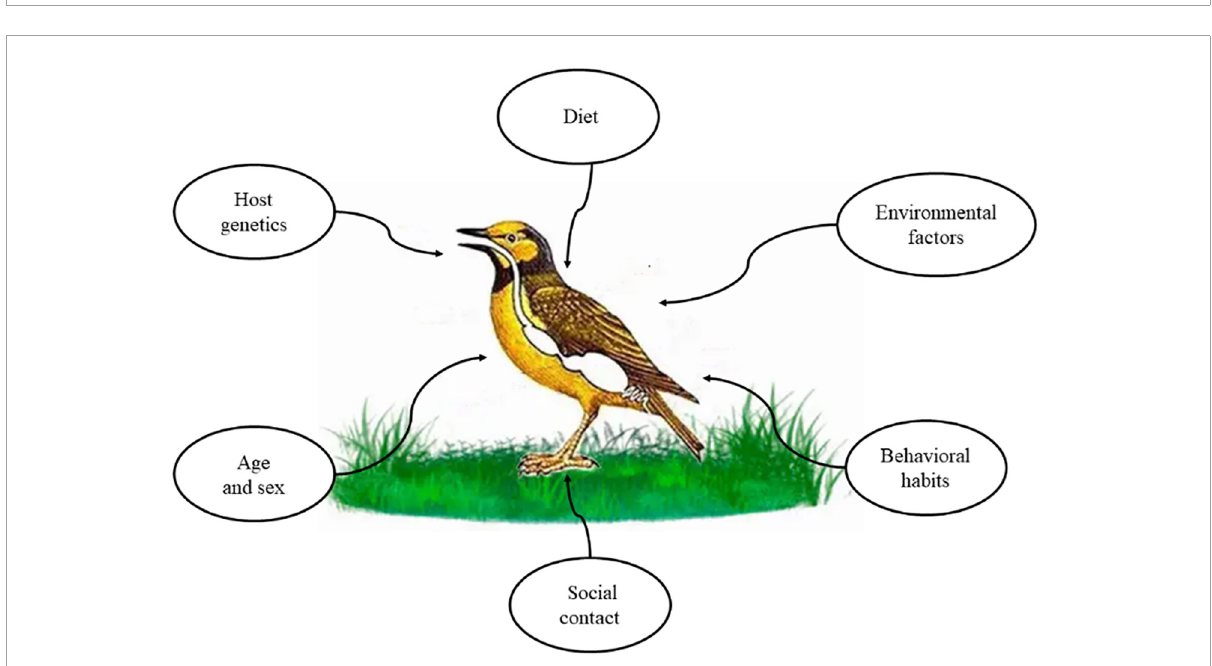
FIGURE6 Main factors shaping avian intestinal